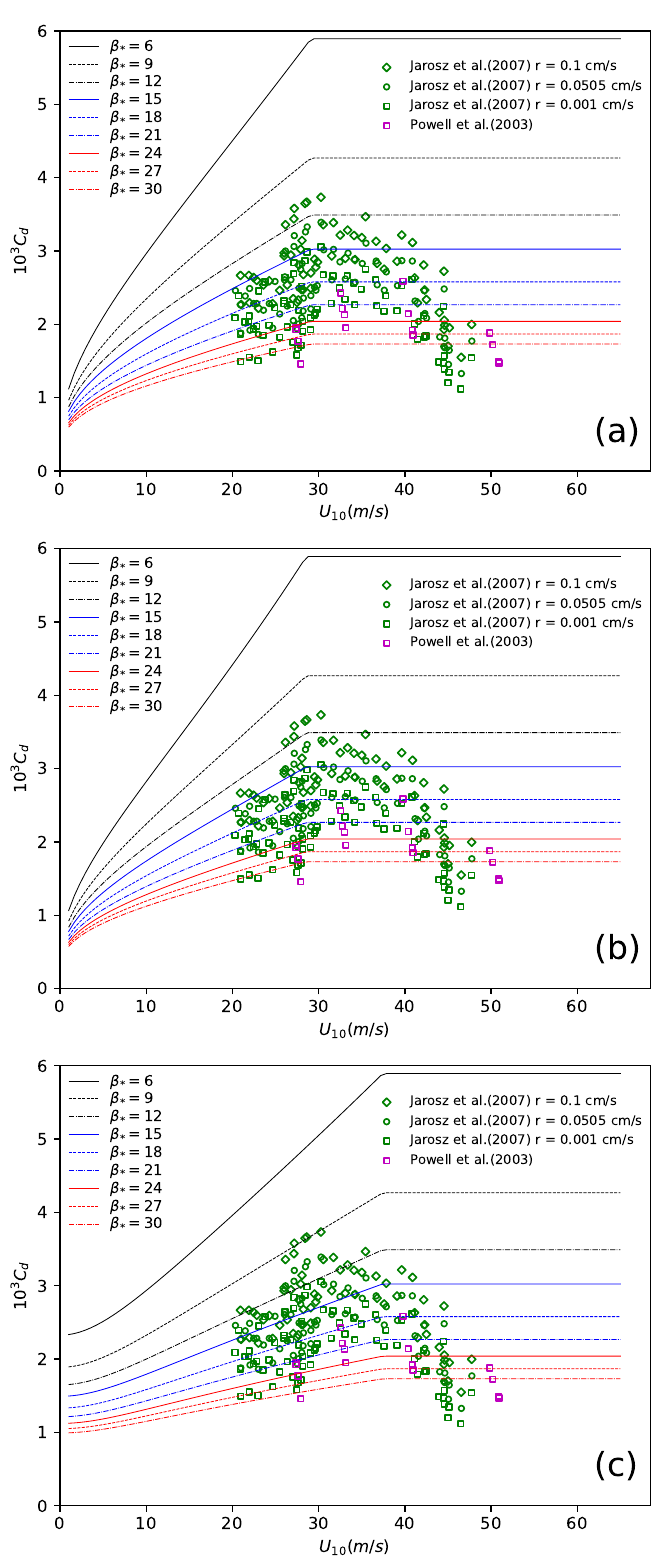
Figure 7. Comparison between C d predicted by the new parameterization without the effect of sea foam (Equation (23)) under different wave ages using H s estimated from ( a ) Taylor and Yelland [51]; ( b ) Fairall et al. [81]; and ( c ) Wang et al. [82] and the field